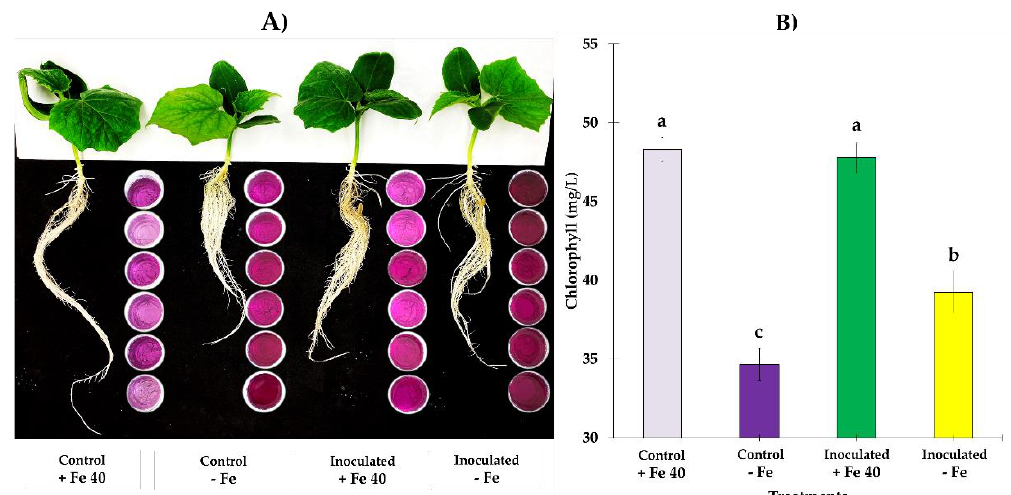
Figure 6. ( A ) General panorama of FRA on roots of C. sativus . On the right side of the roots, the indicator solution containers can be seen at 5 dpi, the FRA is generally highly induced, however, as can be seen in the intense purple color, inoculated plants exceed their respective control; shoots of inoculated plants did not show sever symptoms of chlorosis like occurred in plants without inoculation. ( B ) Mean of SPAD values from at 7 dpi showed significant difference between control and inoculated plants grown in Fe deficient conditions, exceeding inoculated plants their respective control. Letter over the bars denote significant difference between plants inoculated and control plants analyzed by completely randomized ANOVA followed by a Tukey test ( p < 0.05).